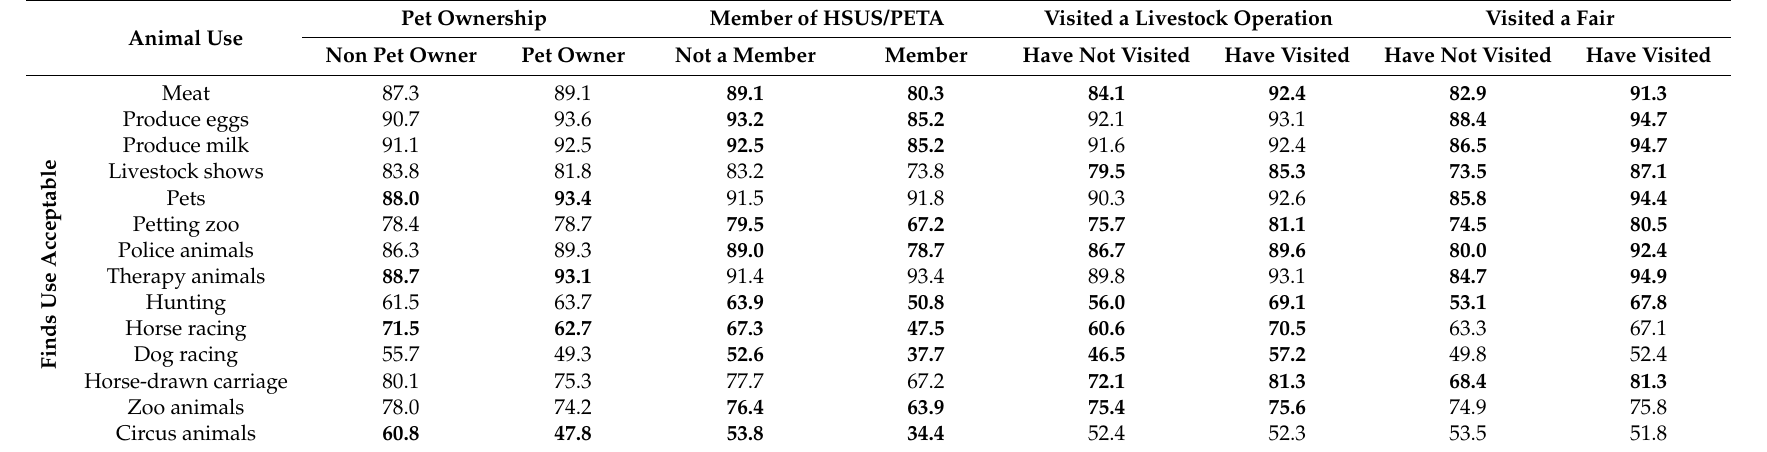
Table 4. Cross tabulations between acceptable animal uses and animal